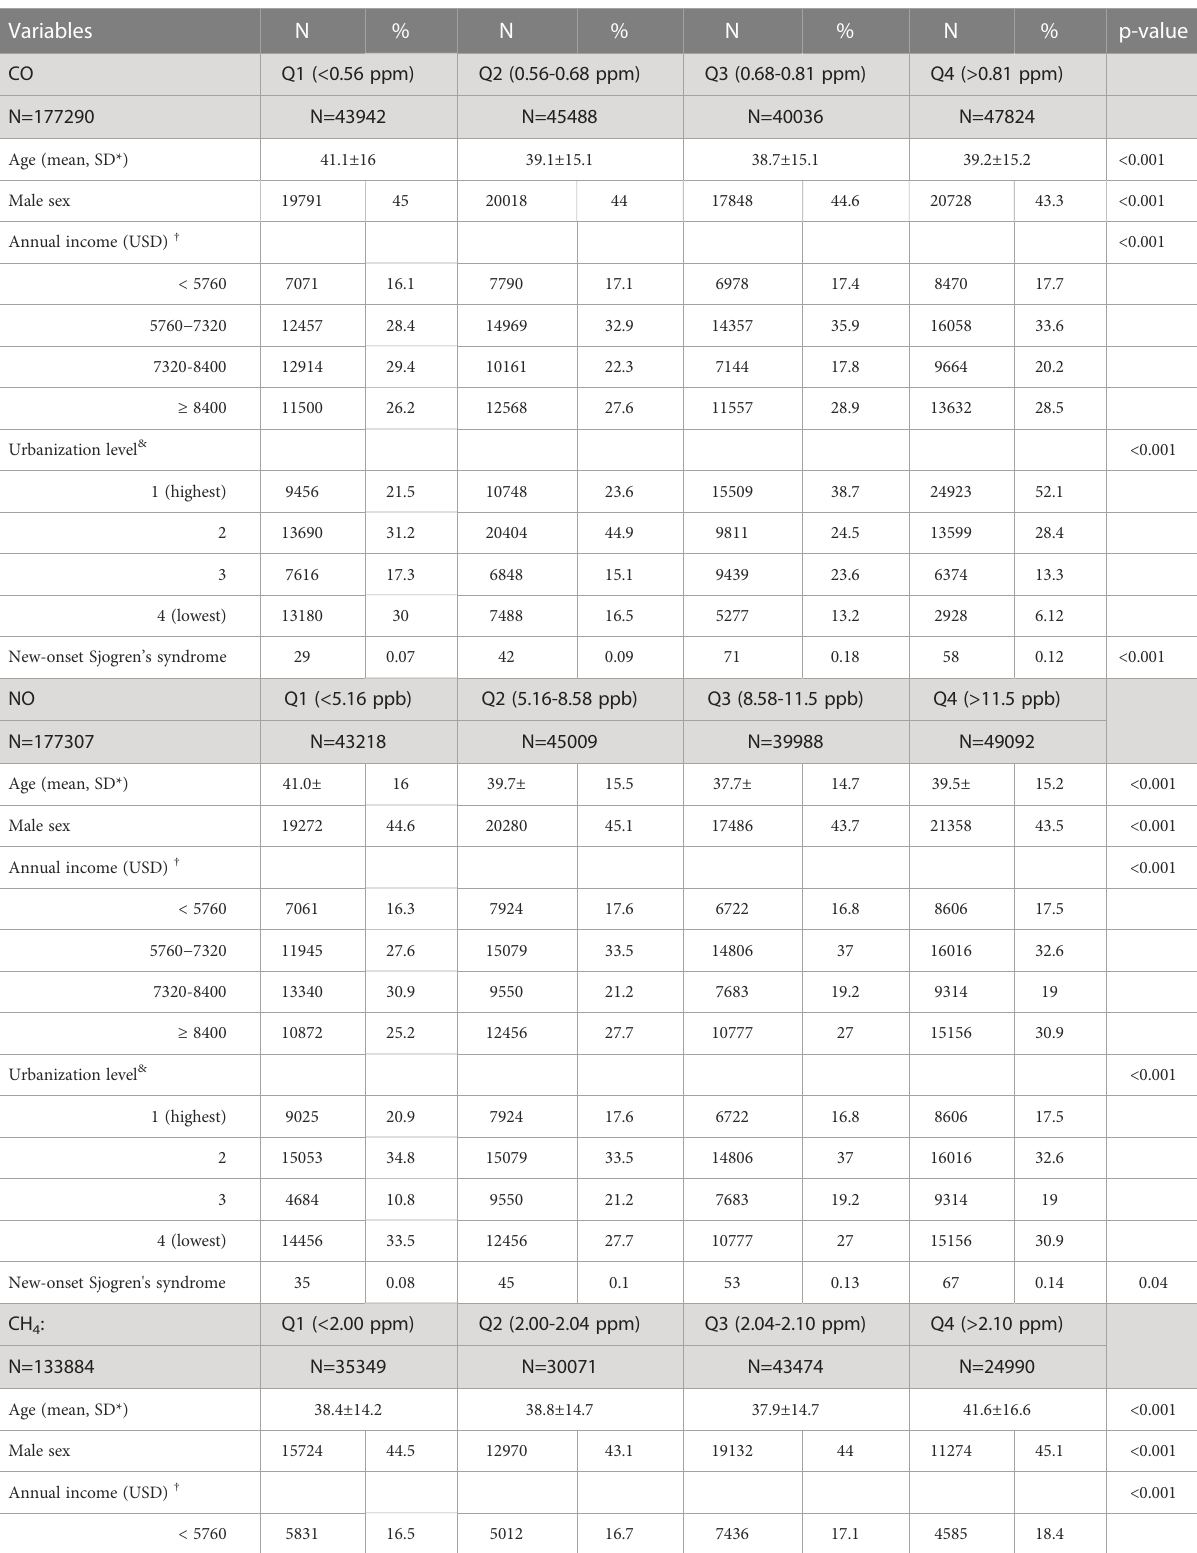
TABLE 1 Patient